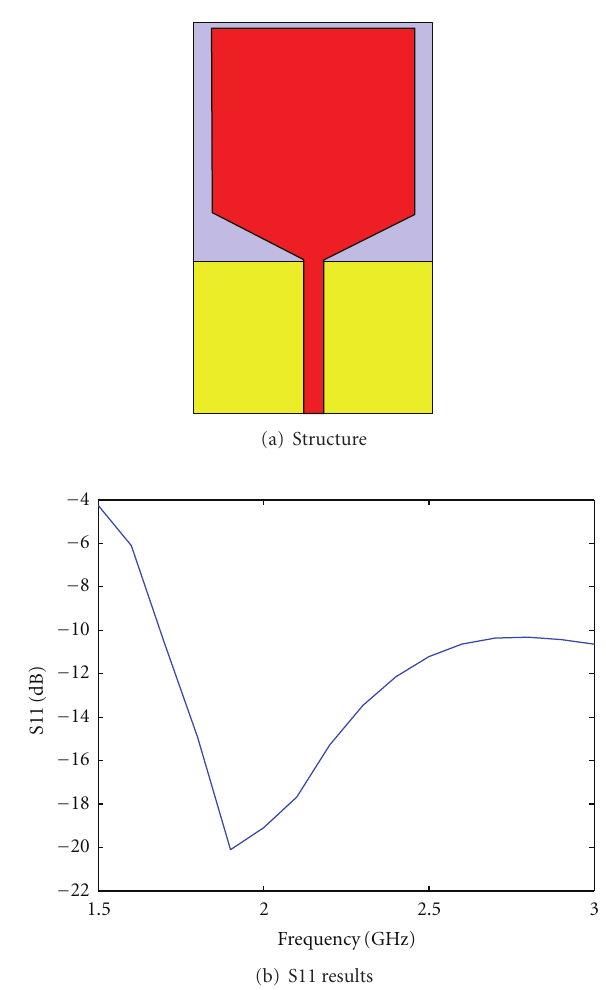
Figure 2: The structure and return loss of the ultra-wideband mo- nopole